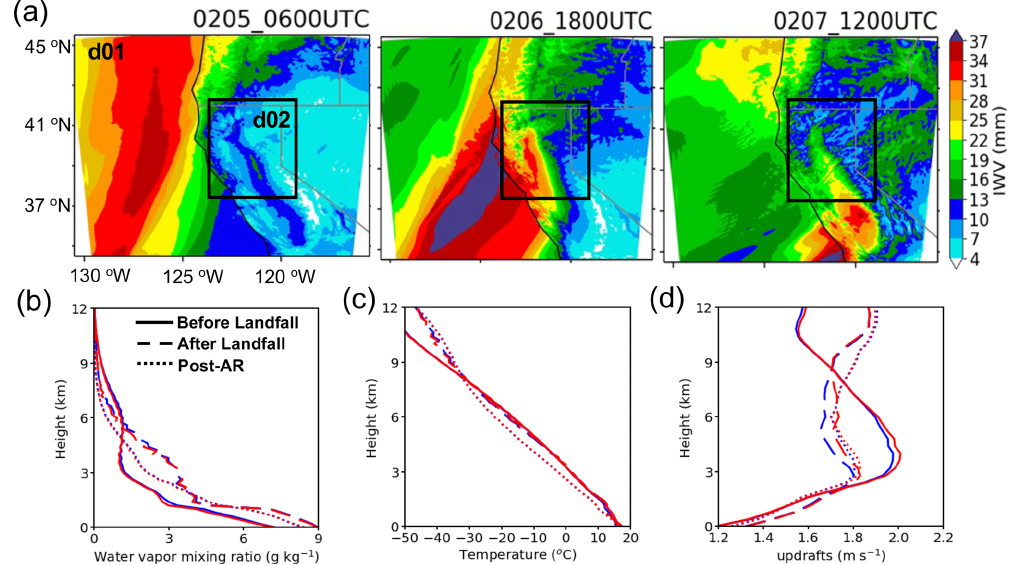
Figure 2. (a) Evolution of integrated water vapor (IWV) at 06:00 UTC on 5 February (before AR landfall), 18:00 UTC on 6 February (after AR landfall), and 12:00 UTC on 7 February (post-AR). The black box (i.e., d02) in (a) is the domain of this study with the five lateral boundary grids excluded for analysis at each side. (b–d) The mean vertical profiles of (b) water vapor mixing ratio, (c) temperature, and (d) updraft velocity at the three AR stages, i.e., before (solid lines) and after (dashed lines) AR landfall and post-AR stages (dotted lines), for the simulations of DM15 (blue) and DM15 + MC18 (red). The water vapor mixing ratio and temperature are averaged for cloud-free grids, and updraft velocity is averaged over the grids with a vertical velocity greater than 1ms − 1